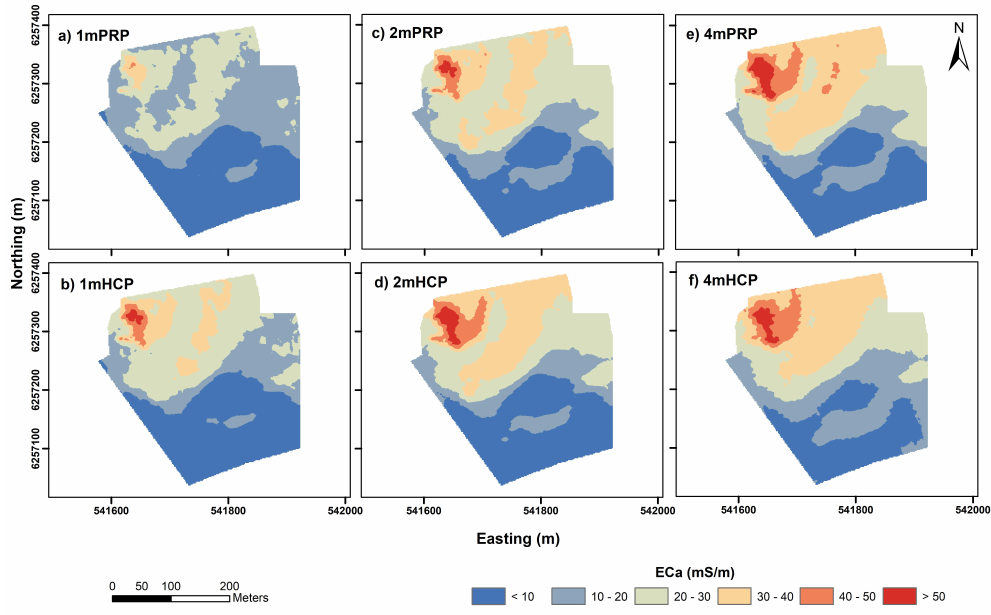
Figure 5. Contour plots of the interpolated apparent electrical conductivity (EC a —mS/m) collected using the six different coils configurations of a DUALEM-421S instrument: ( a ) 1mPRP, ( b ) 1mHCP, ( c ) 2mPRP, ( d ) 2mHCP, ( e ) 4mPRP and ( f )